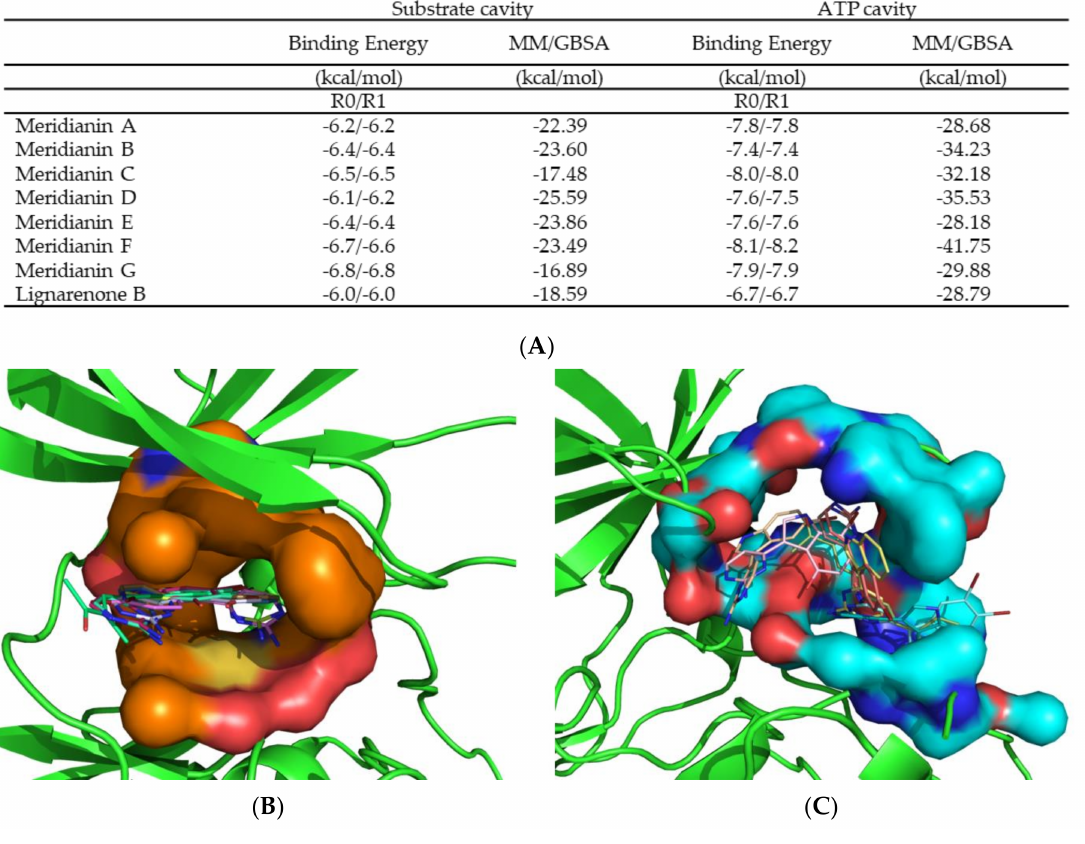
Figure 4. Representation of the two binding cavities ATP and substrate in surface, the binding mode of the marine molecules and the summary of the binding energy results. ( A ) Binding energy results after docking calculations and after 1 ns molecular dynamics (MD) simulations with molecular mechanics / generalised born surface area MM / GBSA calculations. All energies values are in kcal / mol. ( B ) The ATP pocket with all the meridianins and lignarenone B. ( C ) The substrate pocket also with all the meridianins and lignarenone B. Both images represent the last frame after MD simulation. Meridianin A-G colours: Peach, blue, tan, orange, pink, cyan and yellow. Lignarenone colour: